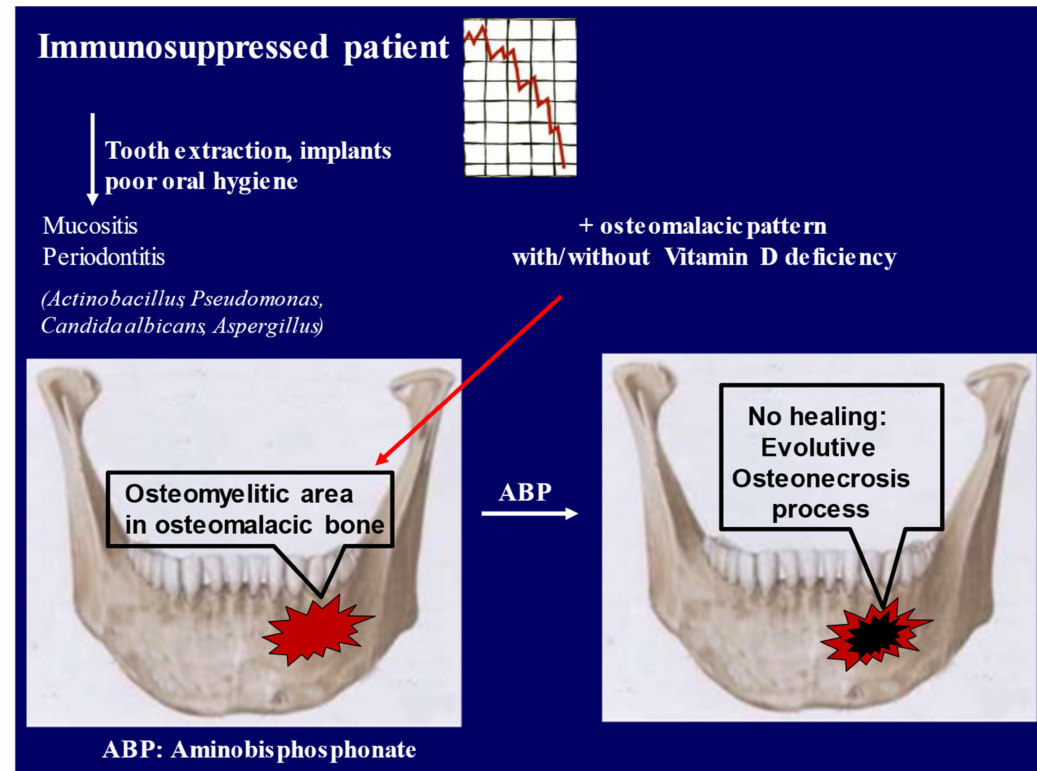
Figure 3. Graphical updated pathophysiologic mechanism of medication-related osteonecrosis of the jaw (MRONJ): In immunosuppressed patients (causes: cancer, chemotherapy, corticoids), surgical interventions and/or poor oral hygiene promote an osteomyelitis complication. In the presence of osteomalacic bone, the use of aminobisphosphonates (ABPs) contributes, through several pathways, to hamper bone healing and to promote the osteonecrosis